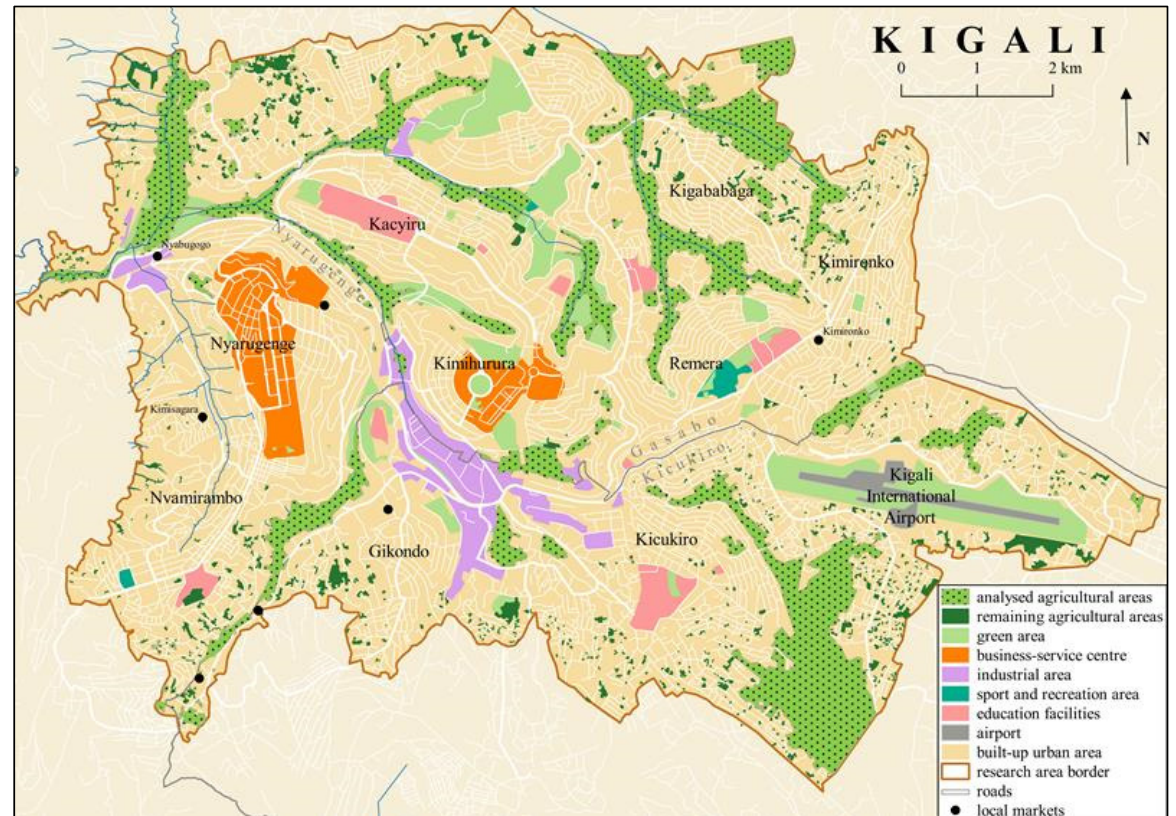
Figure 5. Land use and spatial distribution of urban agriculture in Kigali. In the central parts of Kigali, small, cultivated plots on slopes and hilltops are less frequent. The agriculture is concentrated here mainly in vast valley bottoms. This is mainly due to high building density in central sectors. The short distances between build- ings limit the possibility for cultivation and setting up vegetable gardens. However, the further away from the center of Kigali, the share of micro-scale agricultural sites located on slopes and hilltops increases significantly. This results from the decline in the building density toward the outskirts of the city. The majority of small, cultivated plots are located on the outer parts of the research area, characterized by the least compact spatial form. In turn, in Singapore, farms of a small total area dominate in the central parts of the city, while large-scale farming is concentrated in the periphery, mainly within the Kranji Coun- tryside. In Kigali, the spatial distribution of agriculture is, in part, a manifestation of the needs of the capital city’s inhabitants. Unlike in Singapore, farming is mainly carried out in the immediate vicinity of residential buildings, sometimes taking the form of the so-called ‘kitchen garden’ in a person’s backyard. What can be regarded as a spatial similarity be- tween Kigali and Singapore is that urban agriculture is present alongside green areas that are highly valuable from the natural point of view. In the case of Singapore, these are the natural wetlands in the Kranji Countryside, while in Kigali, they take the form of wetlands in valley bottoms. In addition, in neither of the cities does agriculture appear commonly in areas in which the services sector or administration hold sway. Hence, the small num- ber of urban farms in Singapore’s downtown, and their absence from the summits of the Nyarugenge and Kimihurura heights in Kigali (which, according to spatial planning doc- uments, are to become prestigious service–business centers).